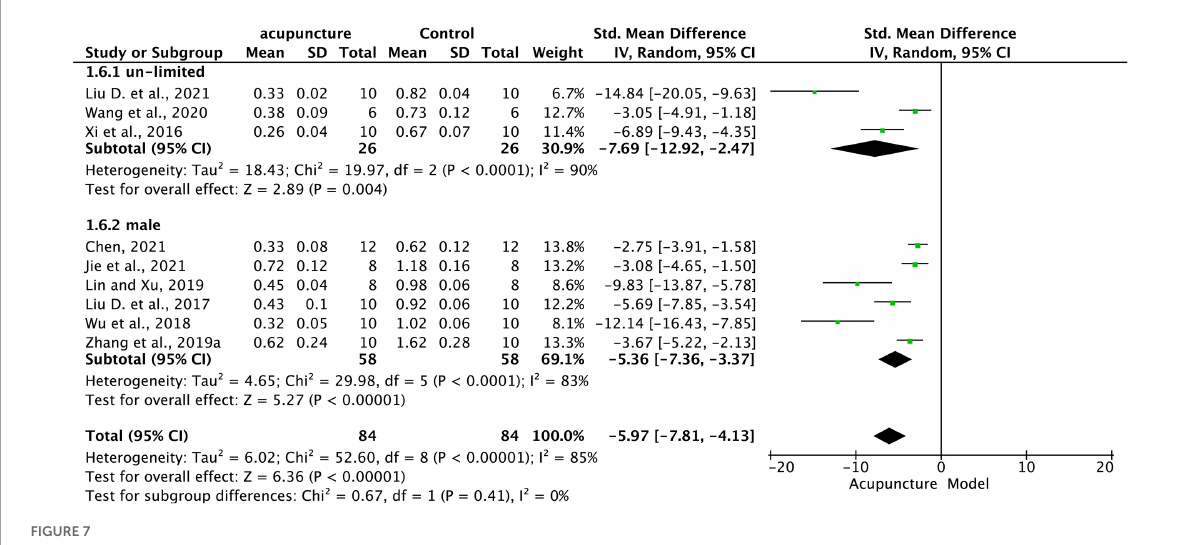
FIGURE7 Subgroup analysis of MMP-13 in KOA cartilage treated with acupuncture in animal models of different gender distributions (male and un-limited).